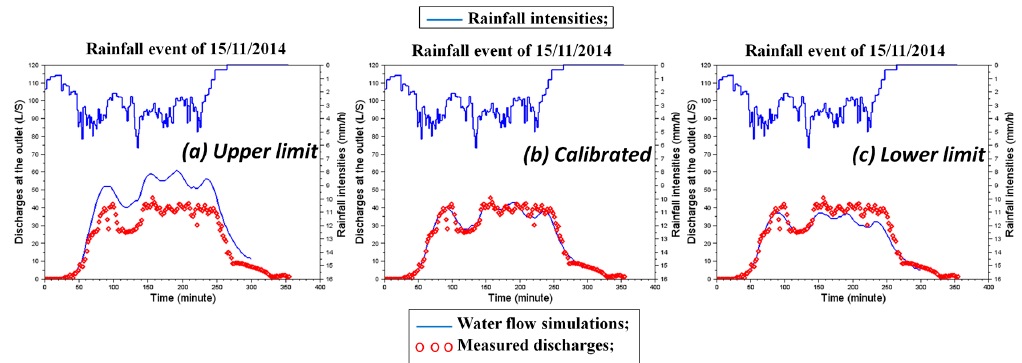
Figure 9. Hydrogram at the outlet of catchment using different values of water flow parameters. For ( a ) simulation using the upper limits of the parameter values; ( b ) simulation using the calibrated parameter values; ( c ) simulation using the lower limit of the parameter values. The simulated discharges at the outlet (solid blue line) are compared with the measured data (red circles). Rainfall is plotted on the upper part. Table 6. Influences of parameter values on water flow at the outlet of the sewer system.